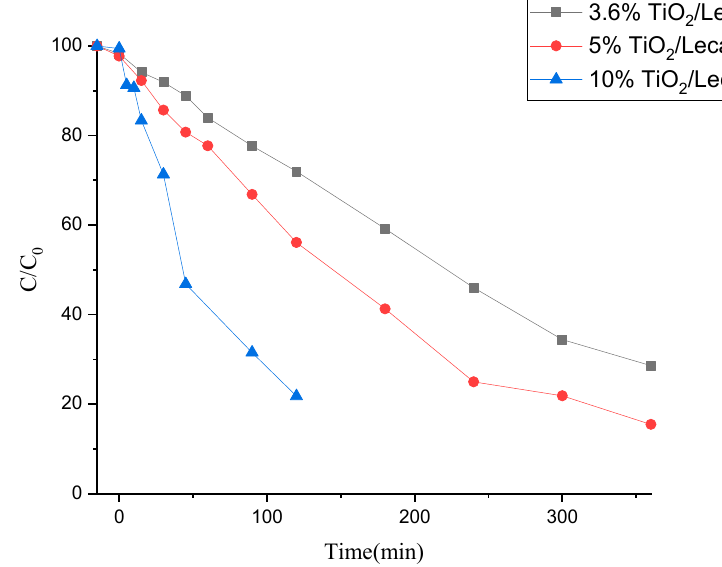
Figure 4. Degradation of SMX for the three photocatalysts using UVA radiation.